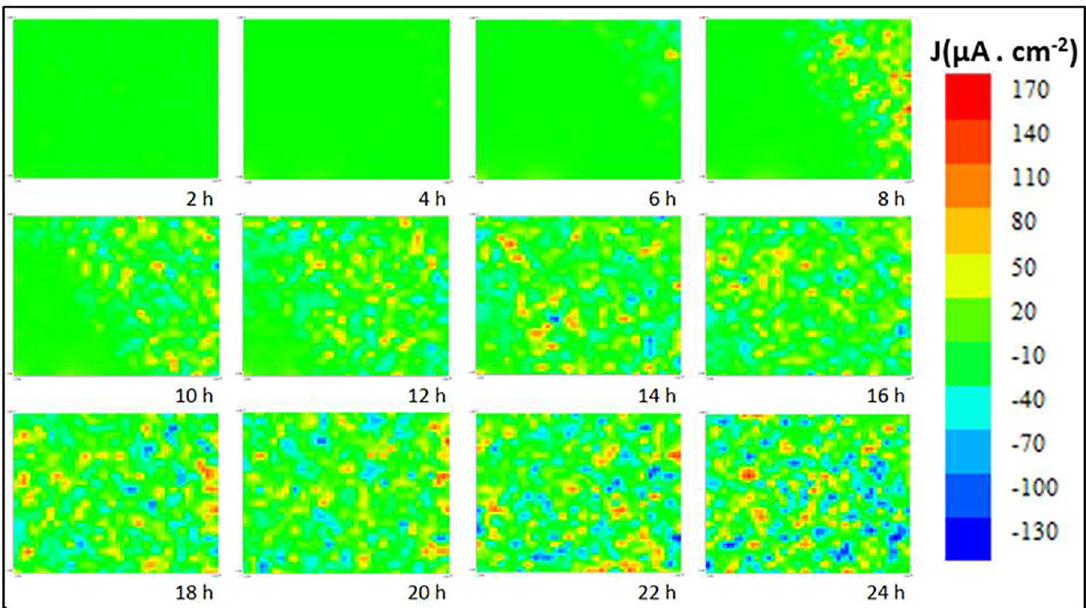
Figure 5. SVET maps showing the corrosion behaviour of hot stamped 22MnB5 steel coated with electroplated Zn-Ni during 24 h of immersion on 0.001 mol·L -1 NaCl